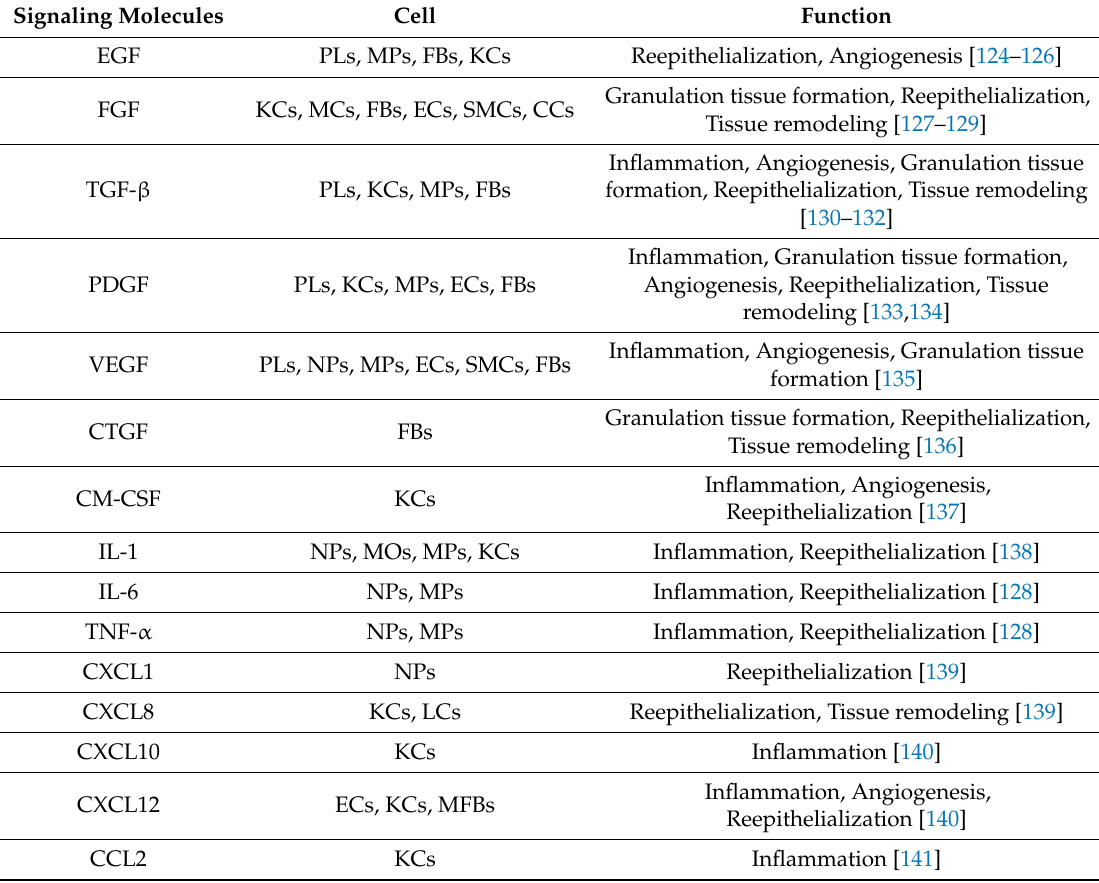
Table 3. Major growth factors, cytokines and chemokines that participate in wound healing. Signaling